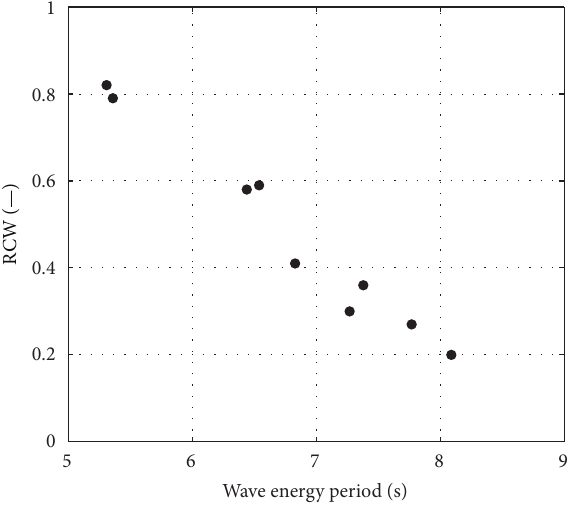
Figure 5: RCW for the optimized linear reactive